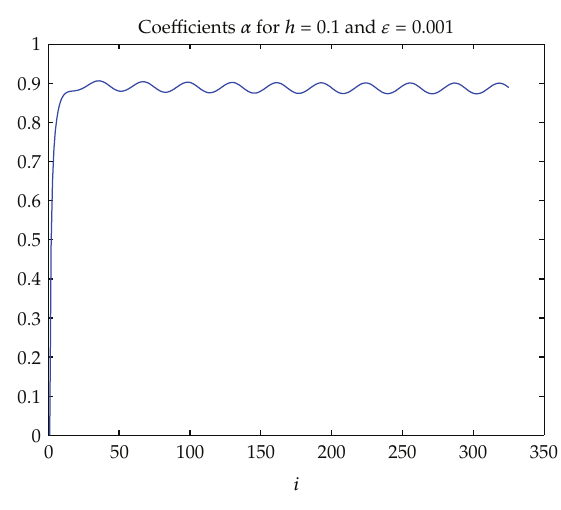
Figure 3: Coe ffi cients α for ε (cid:8) 0 .